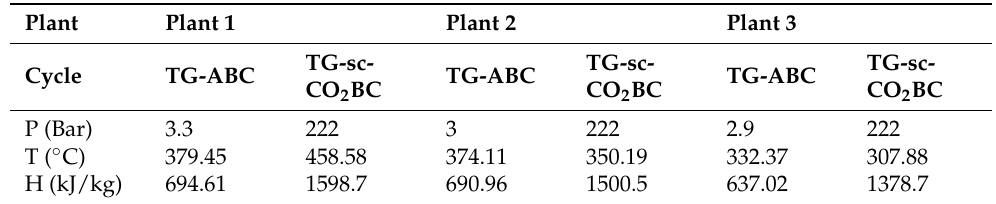
Figure 4. Net output power ( a ), energy efficiency ( b ), and exergy efficiency ( c ) for the different plants with the three cycles. Table 12. Bottoming turbine inlet calculated pressure, temperature, and enthalpy for the different plants with TG-ABC and TG-sc-CO 2 BC.